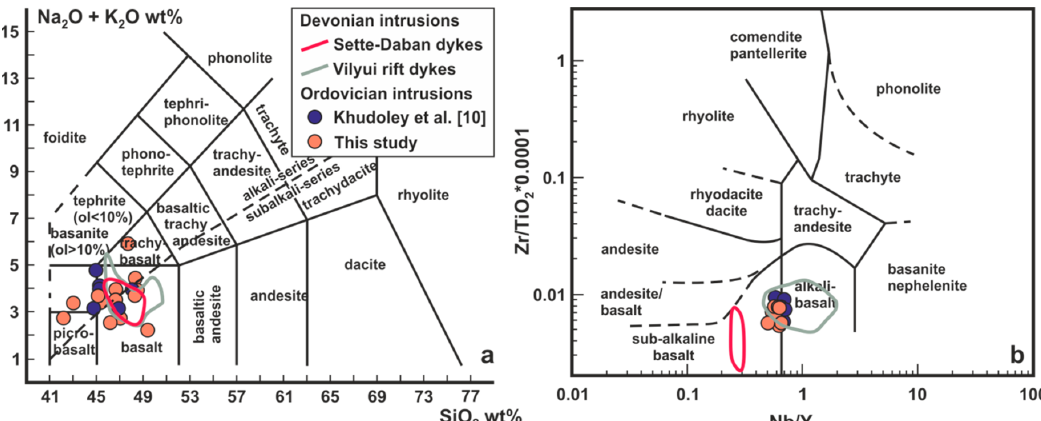
Figure 7. Classification diagrams for the Ordovician Suordakh event mafic intrusions cutting the Gornostakh Anticline [10] and those cutting Cambrian units as well (this study). ( a ) Total alkalis vs. silica (TAS) [42,43], ( b ) Zr/TiO 2 vs. Nb/Y [44]. Fields of the Devonian Sette-Daban dykes and Vilyui rift dykes (of the Yakutsk-Vilyui LIP) are shown for comparison, after [29,45]. See location of the Vilyui rift in Figure 1 (inset). On the TAS diagram, composition fields of the Ordovician and Devonian intrusions overlap each other, whereas on the Zr/TiO 2 vs. Nb/Y diagram, the Ordovician and Devonian Vilyui rift intrusions occupy similar fields but the Sette-Daban Devonian dykes differ from them.